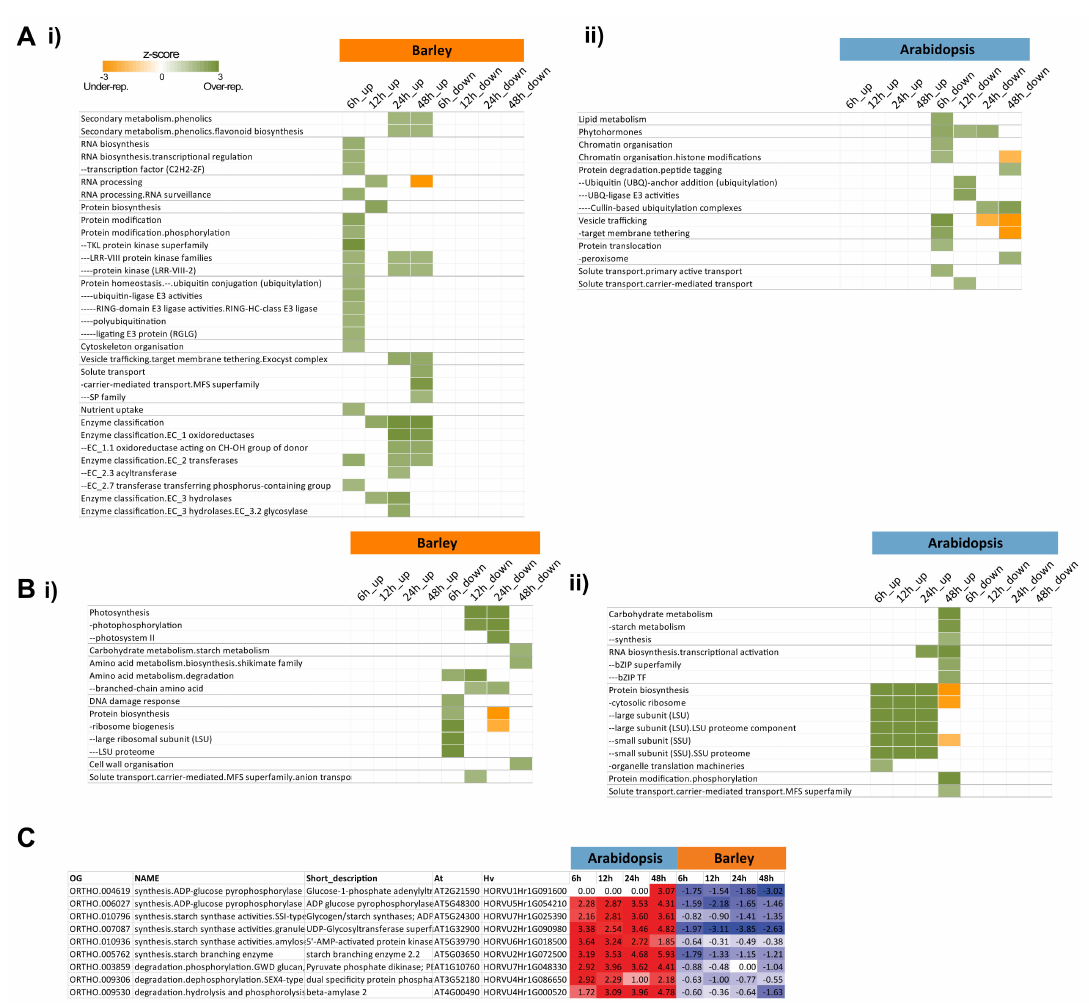
Figure 5. Analysis of genes showing the distinct responses during seed germination in barley and Arabidopsis. ( A ) The oppositely responsive gene sets in barley and Arabidopsis were analyzed for significantly over-represented functional categories (Fisher’s test, p < 0.05) using Pageman [37], and the outputs for the genes that were (i) upregulated in barley and orthologous to the (ii) downregulated genes in Arabidopsis are shown. ( B ) The significantly over-represented functional categories for the genes (i) downregulated in barley that were orthologous to the (ii) upregulated genes in Arabidopsis. ( C ) Orthologous genes encoding starch synthesis functions that showed opposing responses between barley and